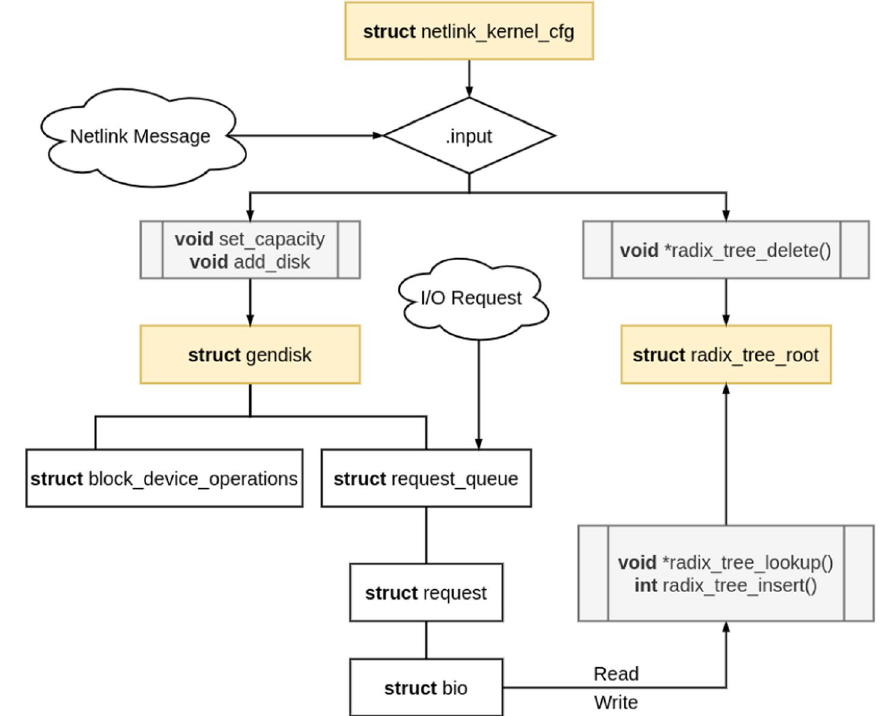
Fig. 9 The kernel module of an elastic block device as a storage on a lender